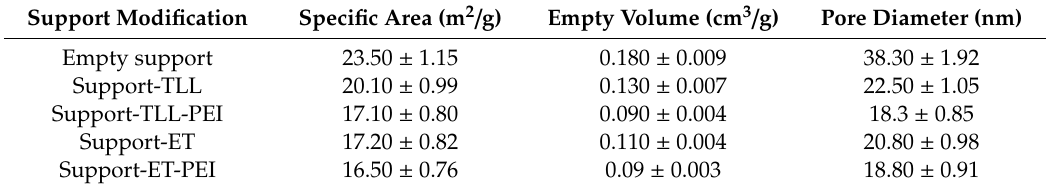
Table 1. Textural properties of the different biocatalysts used in this paper, prepared using octadecyl methacrylate beads (ECR8806M). The experiments were performed as described in the Methods section.